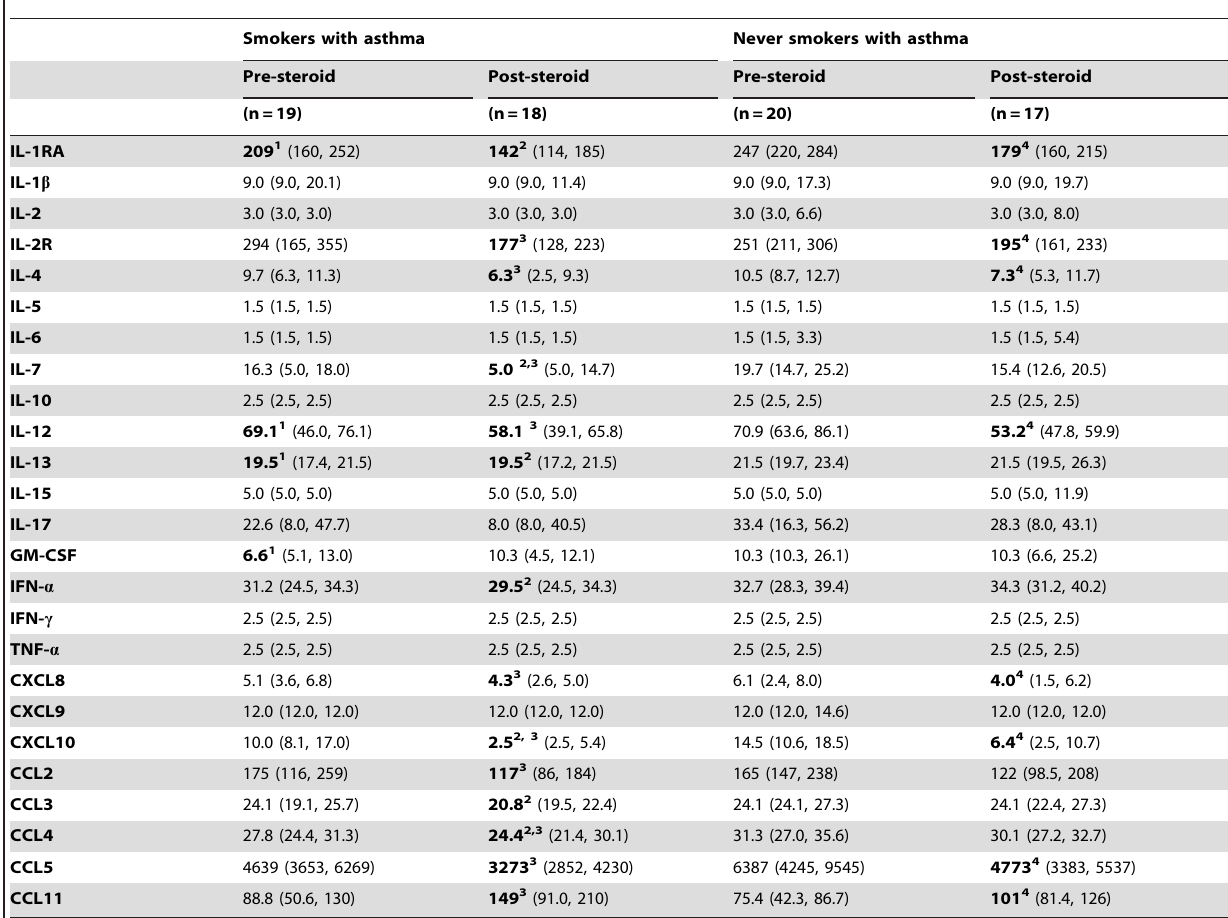
Table 5. Plasma cytokine concentrations before and after two weeks of oral